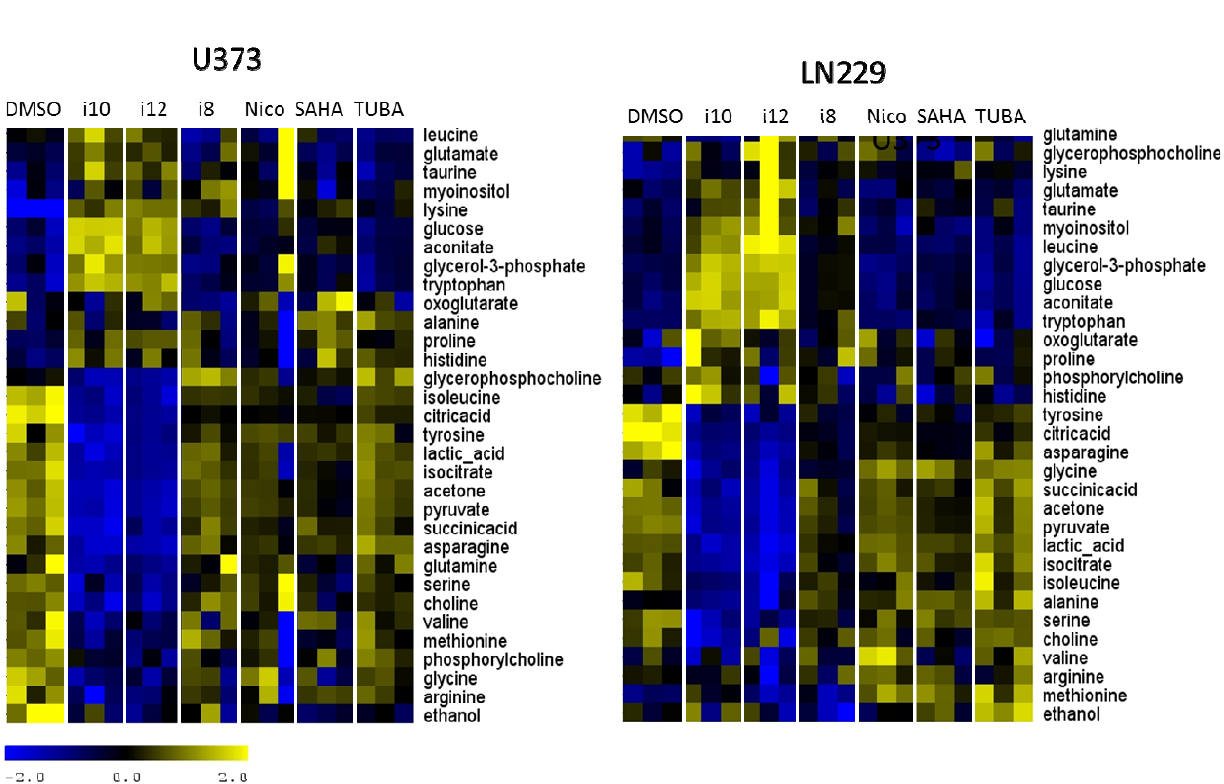
Figure 6. Relative metabolite concentrations for extracellular samples for two cell lines treated with all individual compounds. Concentrations are scaled across samples and normalized across metabolites. Heat maps shown for the two cell lines have been clustered across metabolites for easier